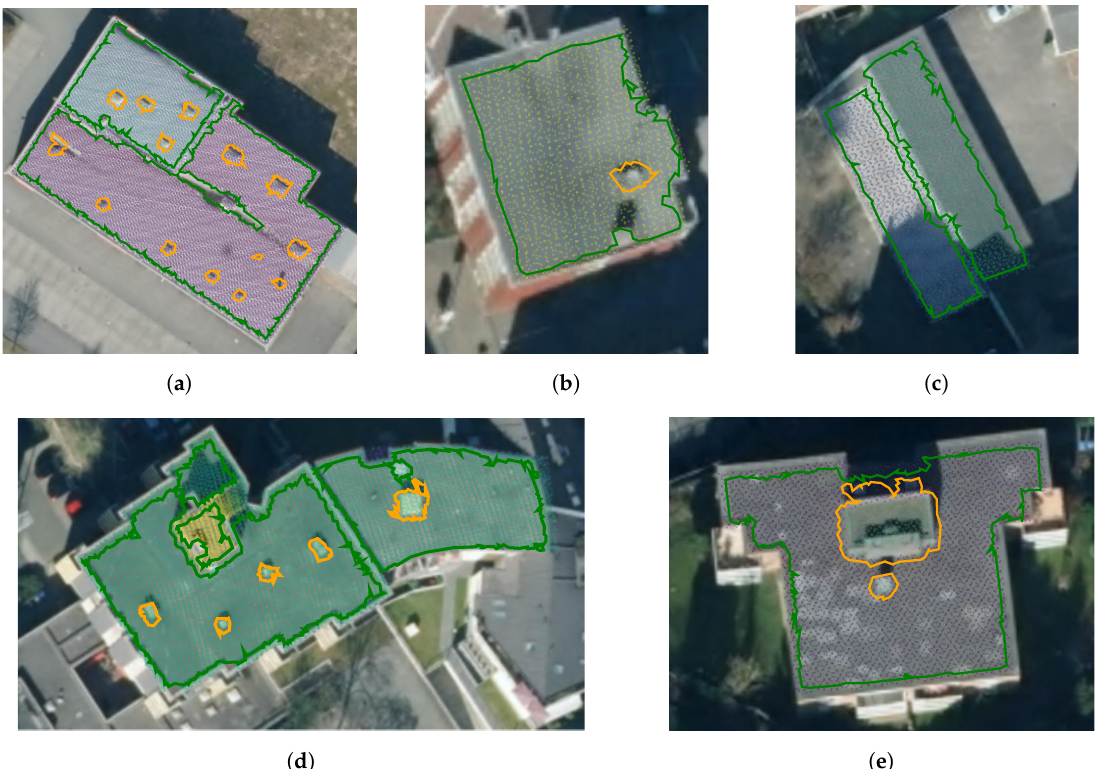
Figure 16. Polygon extraction of rooftops from unorganized 3D point clouds generated by airborne LiDAR. Each figure ( a – e ) shows the satellite image overlaid with the extracted polygons (green) representing flat surfaces with interior holes (orange) representing obstacles. A colorized point cloud is also overlaid ranging from dark purple to bright yellow denoting a normalized low to high